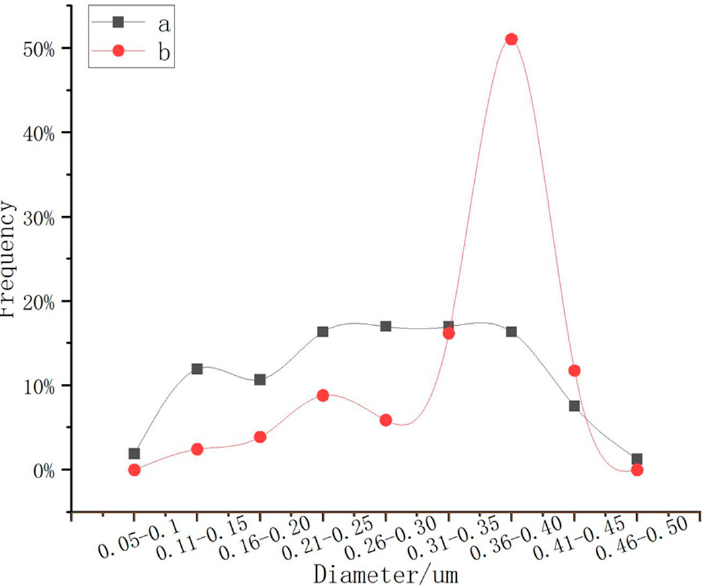
Figure 6. Particle size distribution curves of 150 microspheres. (a) Without using PEG; (b) using PEG.